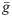
Gini and k indices with number of papers and citations.Variation of Gini and k indices with number of papers and citations for academic institutions and journals. For larger number of papers or citations, the values seem to fluctuate less or converge around the mean values g¯ and k¯ respectively. For academic institutions, the values are g¯≈0.67 for Gini and k¯≈0.75, while for the journals, the values are g¯≈0.58 and k¯≈0.71.